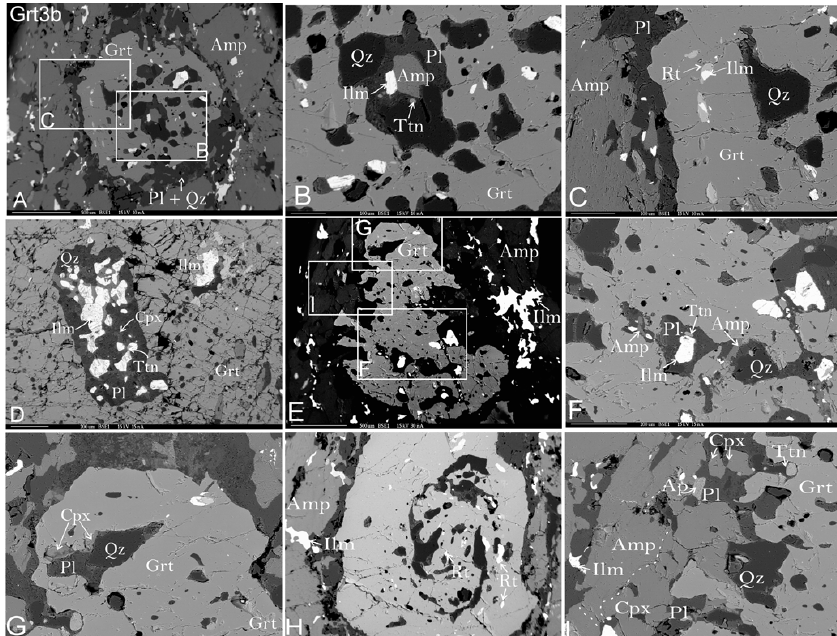
Fig. 4. Back-scattered electron images showing mineral and textural characteristics of the Sabzevar granulites (samples NG353 and NG421). (A) – (C) Poikiloblastic garnet with details on the core-rim distribution of the inclusion assemblages. The Ti-phases inclusions consist of ilmenite-titanite (Ilm 1 /Ttn 1 ) at the garnet core (B) and of rutile that substitute ilmenite at the garnet rim (C) . (D) Garnet core hosting ilmenite pseudomorphs after titanite. The inclusion assemblages also consists of clinopyroxene and plagioclase. (E) Large porphyroblastic garnet with details on the core-rim inclusion assemblages: amphibole occurs at the garnet core (F) , whereas clinopyroxene at the garnet rim (G) . Note that composite ilmenite-titanite (Ilm 1 -Ttn 1 ) assemblages occurs at the garnet core. (H) Rutile-bearing spiral trails of mineral inclusion in porphyroblastic garnet. Ilmenite occurs in the matrix assemblage (Ilm 2 ) . (I) Poikyloblastic garnet and granular texture of the leucocratic quartz-plagioclase segregation. Titanite (Ttn 2 ) and ilmenite (Ilm 2 ) both occurs dispersed in the matrix